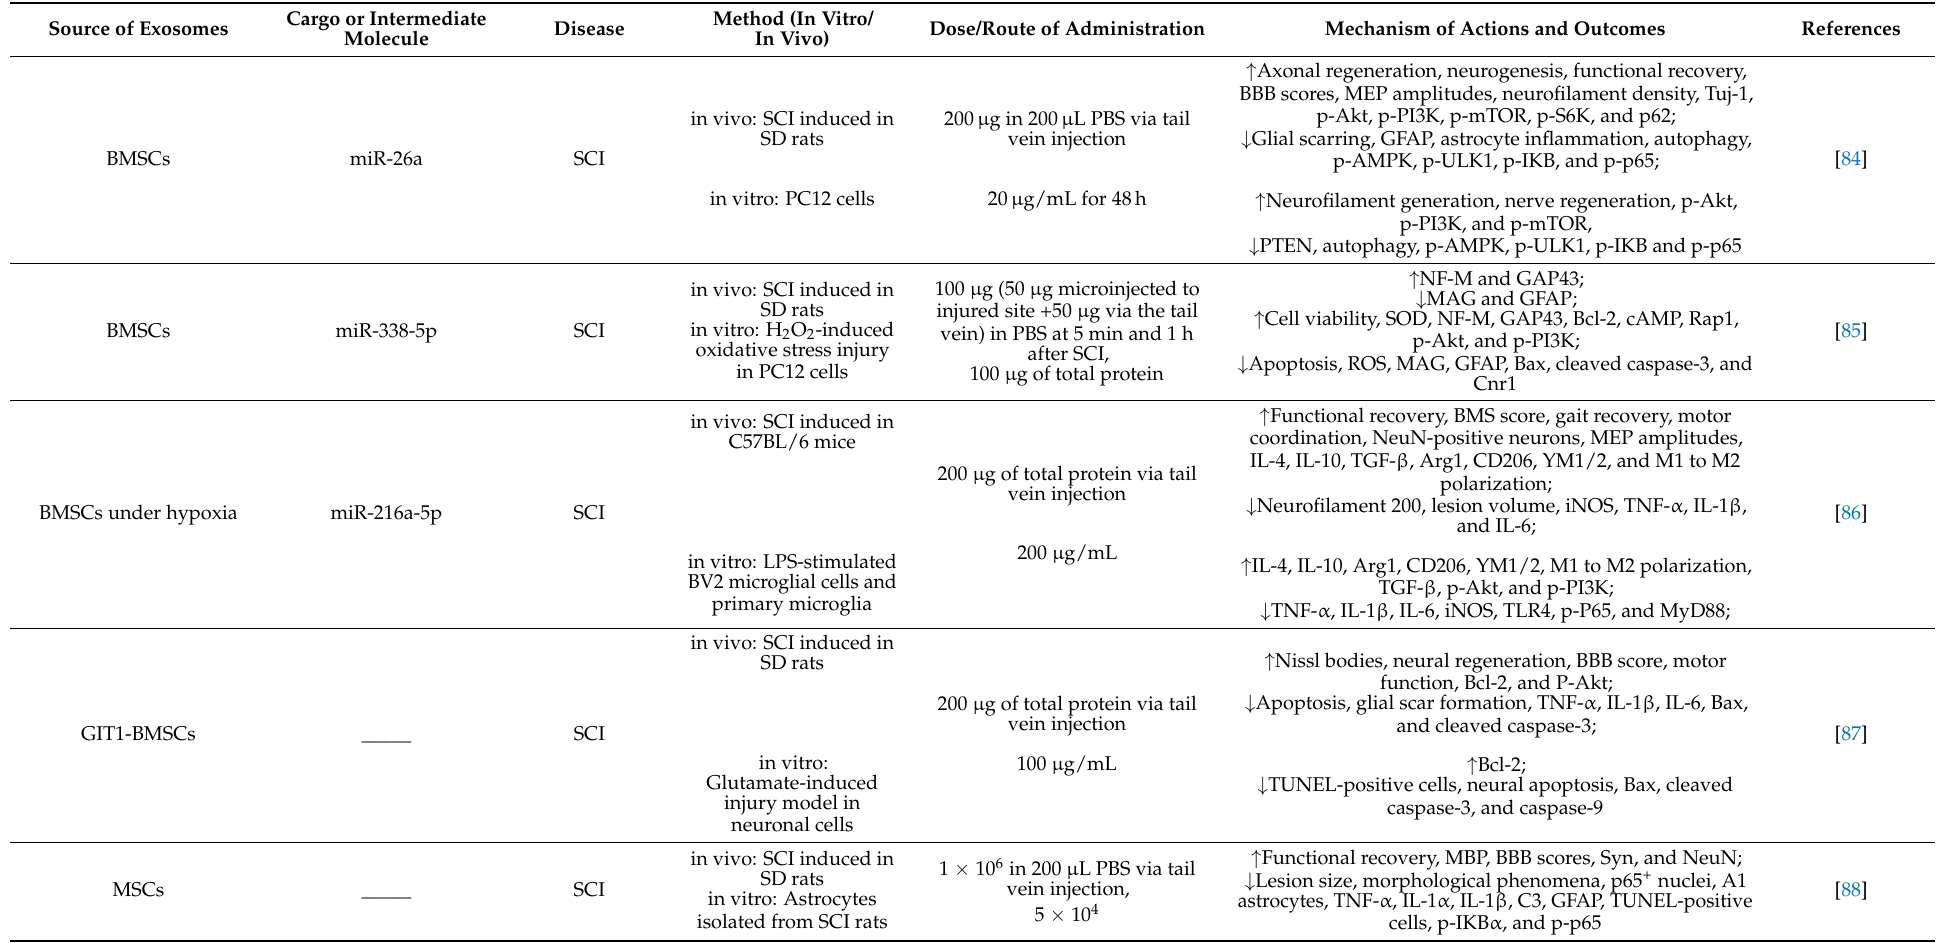
Table 2. Exosomes circumvent SCI and TBI via PI3K/Akt/mTOR and associated